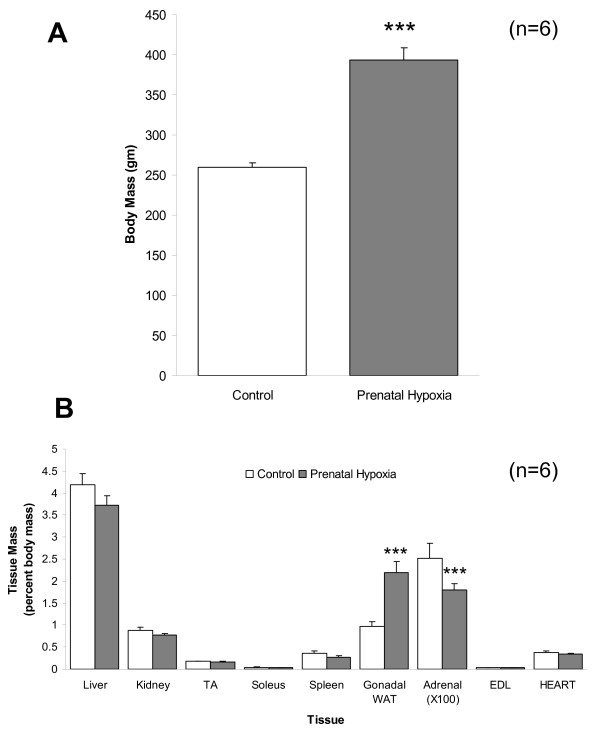
Body and tissue mass at post-mortem. Data represents body (A) and relative tissue masses (B) for control and adult offspring from pregnant female rats exposed to prenatal hypoxia. Tissue masses represented as a percentage of body mass to normalise for differences in body mass between control and CHU rats. Data represents Mean ± standard deviation (n = 6 for both control and CHU rats). Statistical comparisons represent: *** P < 0.001.